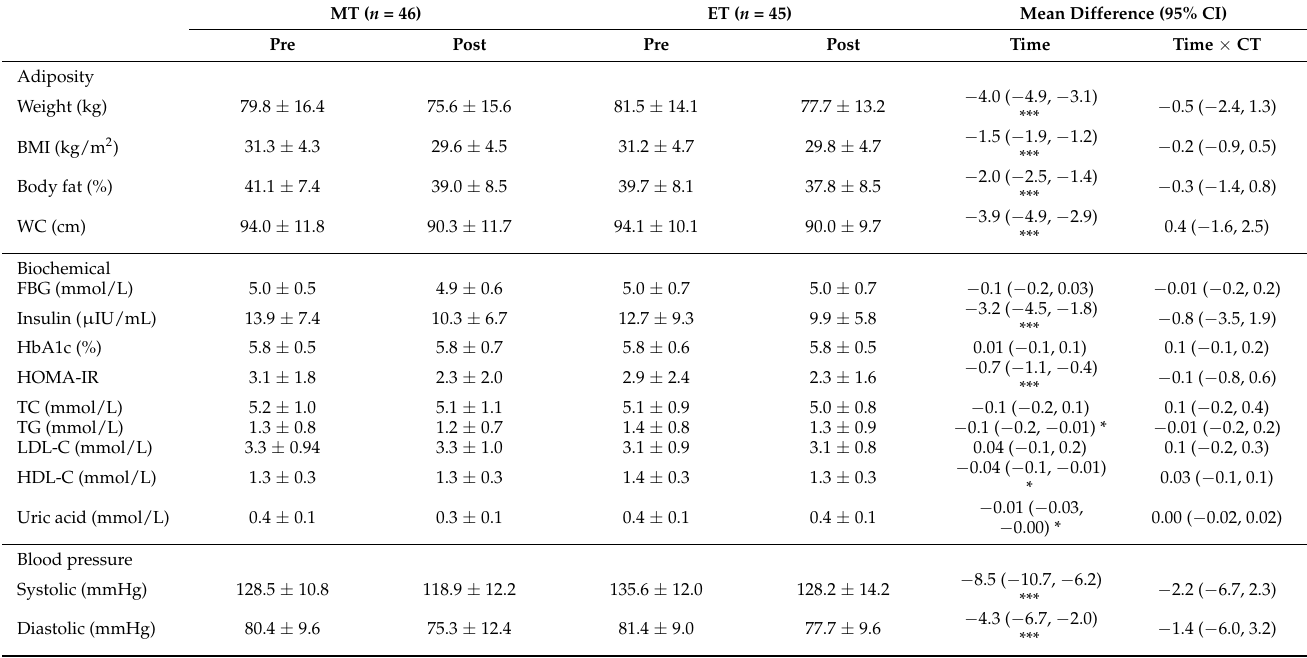
Table 5. Pre–post intervention differences in adiposity, and biochemical parameters.